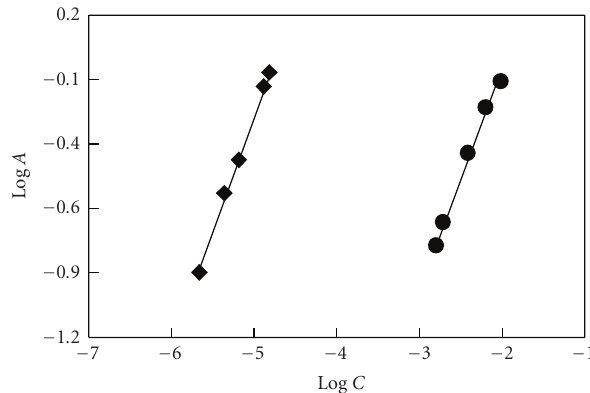
Figure 6: Limiting logarithmic plot for molar reactivity of PRX with NQS. C and A are the concentration and absorbance, respectively. For generating the first line ( (cid:2) ), [NQS]: 1 . 9 × 10 − 2 ; [PRX]: 0.3 × 10 − 5 − 2.04 × 10 − 5 M; Clark and Lubs bu ff er solution